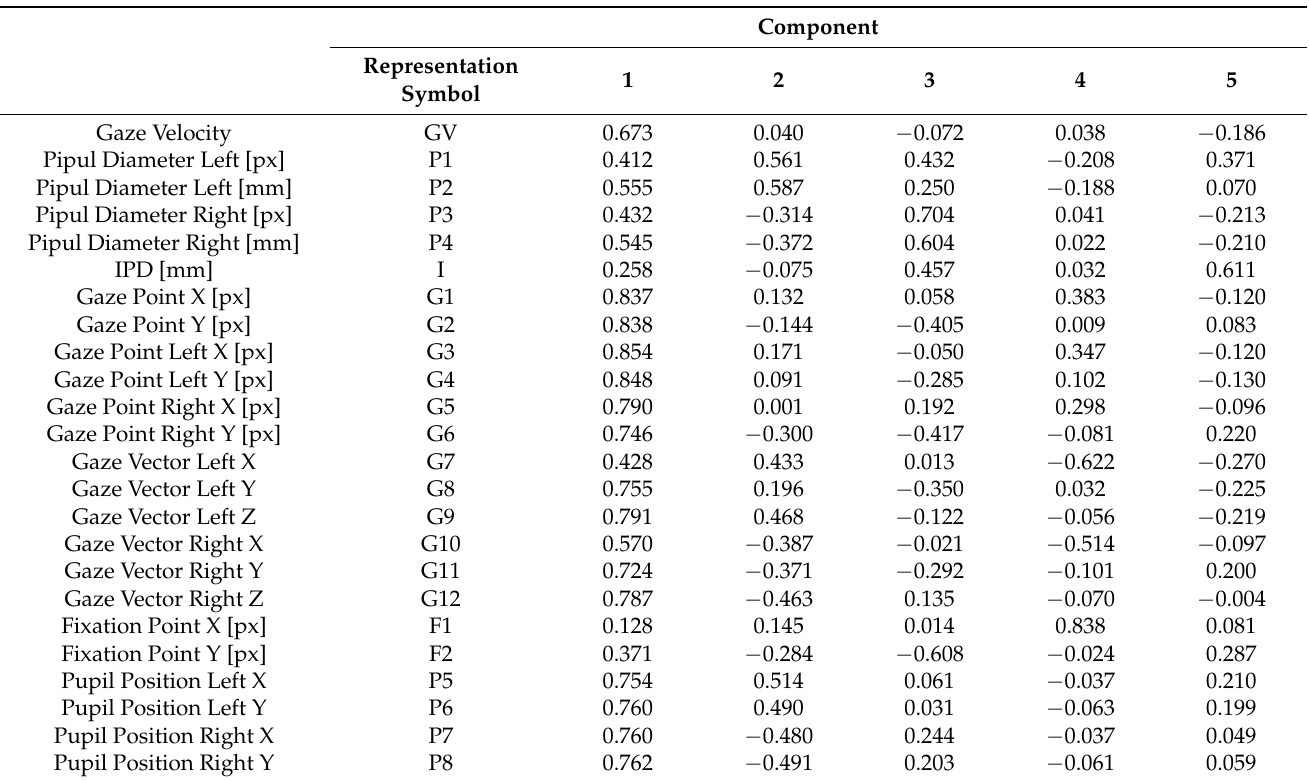
Table 5. Composition matrix of the vehicle driving experimental data.